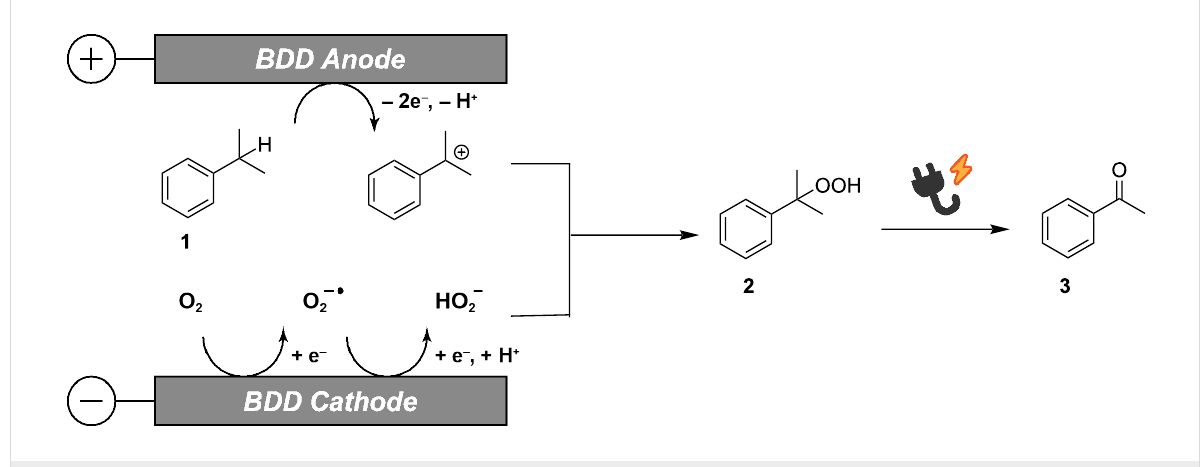
Figure 2: Proposed reaction mechanism of electro-conversion of cumene ( 1 ) into acetophenone ( 3